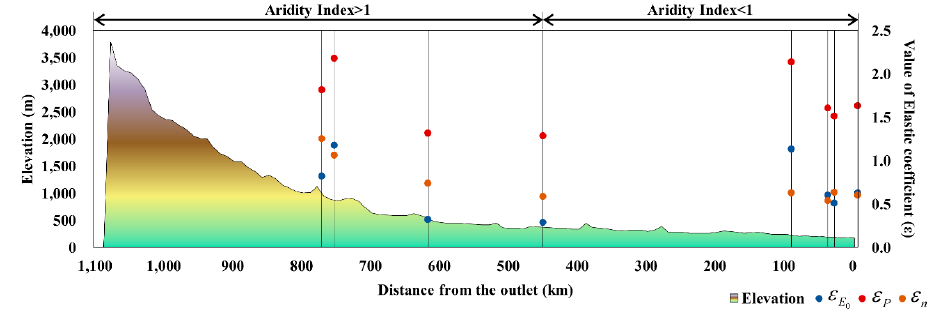
Figure 6. Changes of altitude and elastic coefficients in the Jialing River Basin.